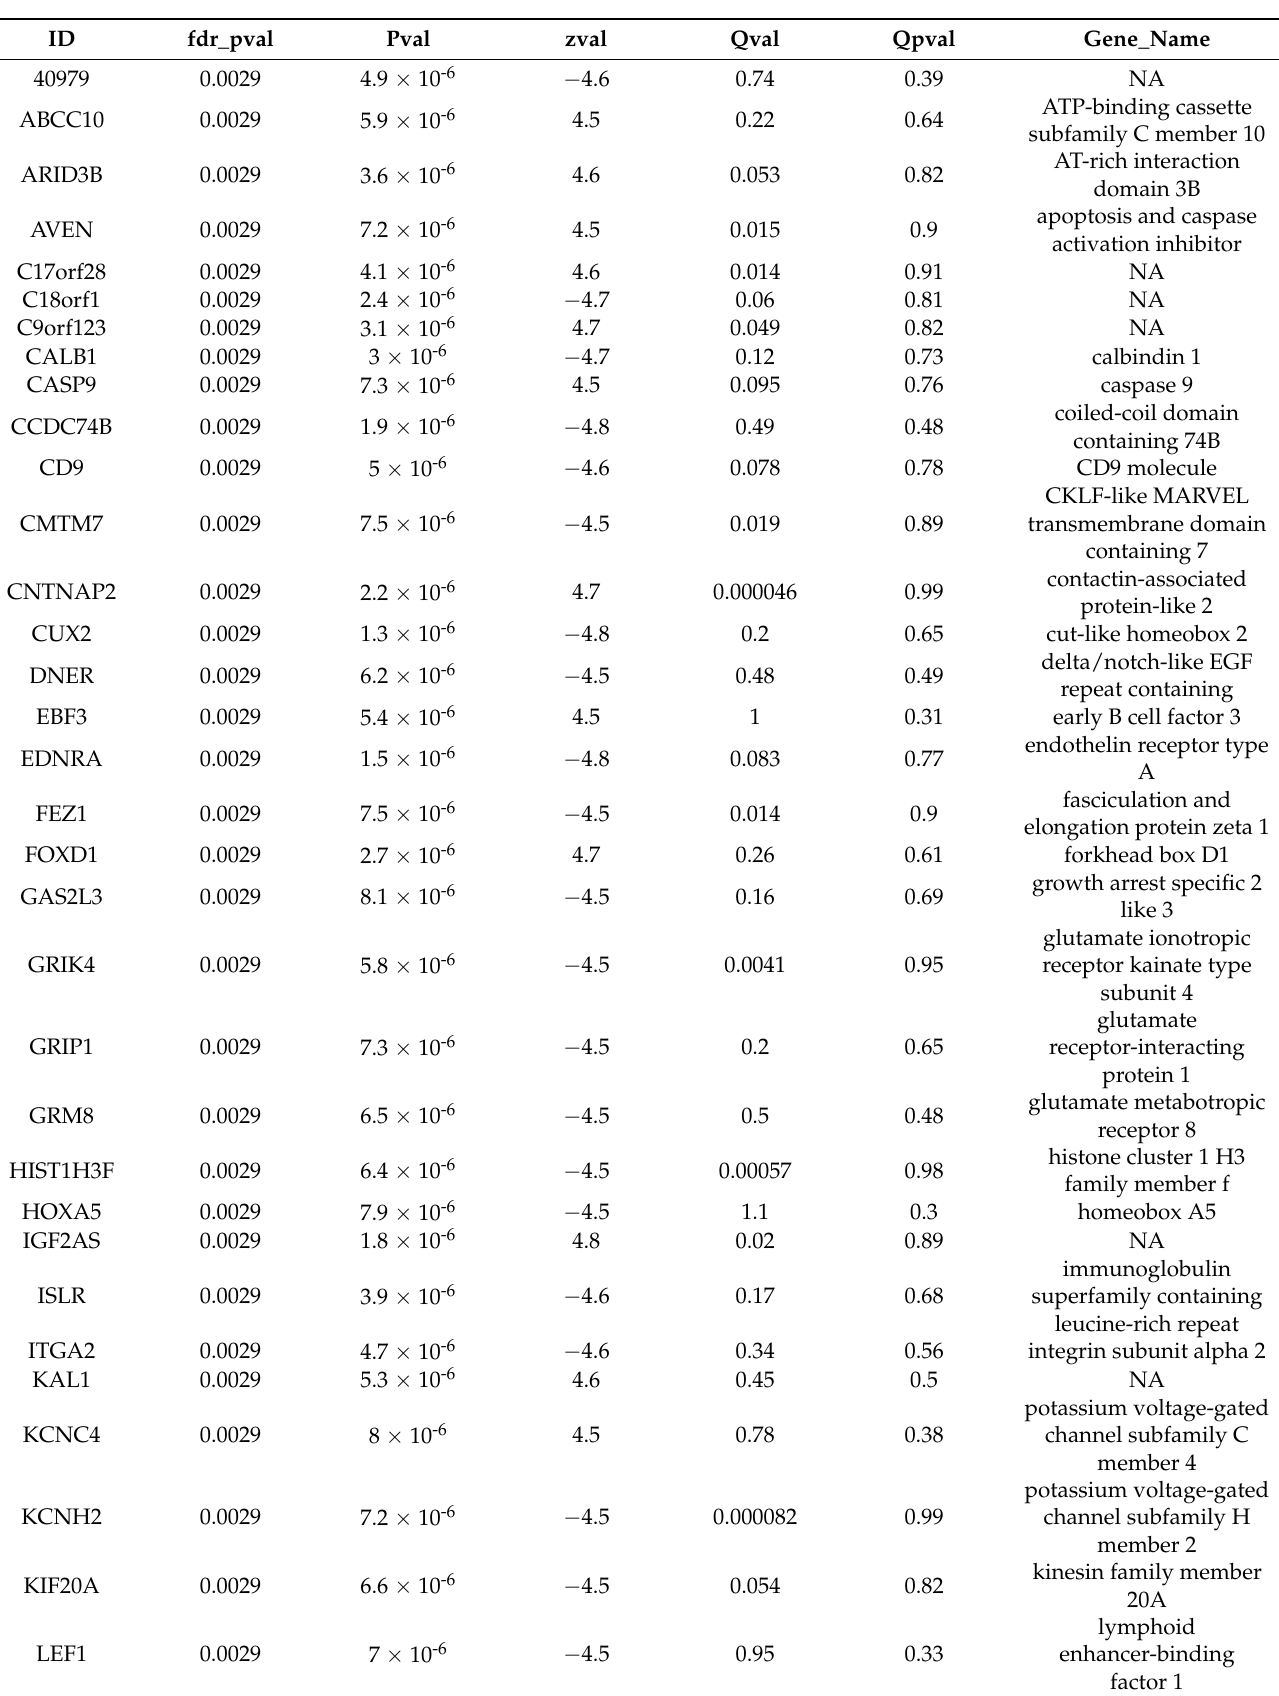
Table 1. Top 50 modulated genes in